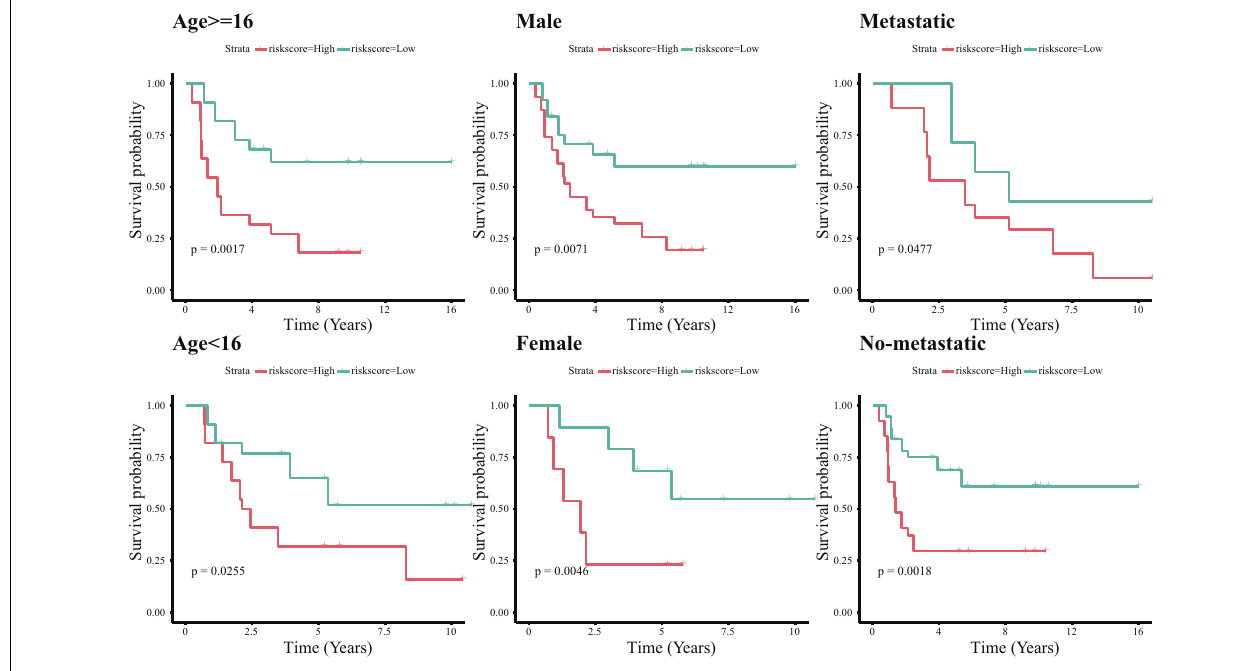
FIGURE 6 | Survival analysis of the immune-related 11-lncRNA signature with different clinical characteristics.